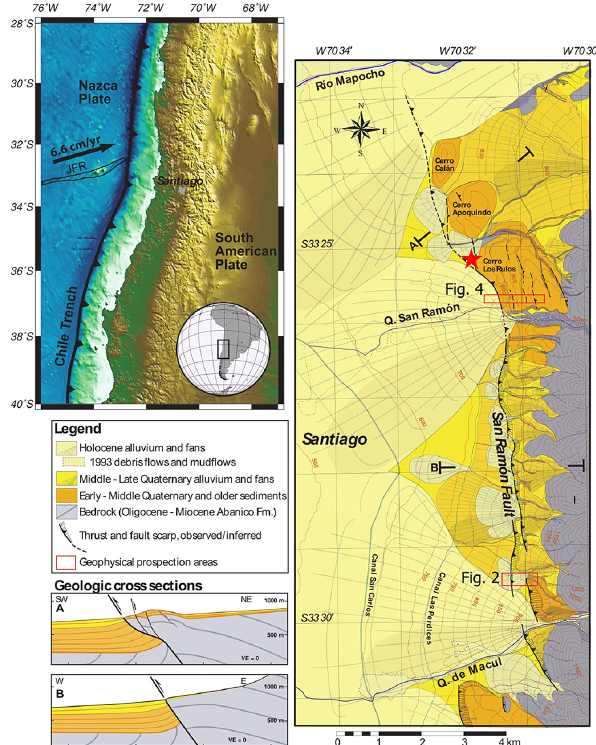
Figure 1. Geological chart (top left panel) and cross sections of the study zone showing the San Ramón fault system along the eastern border of Santiago (bottom left panels), and locations of the geo- physical measurements (right panel) (modified from Armijo et al., 2010). Locations of geophysical measurements are marked by red rectangles, enclosing the areas shown in Fig. 2 (Quebrada de Macul area) and Fig. 4 (La Reina area). A red star marks the position of the Baños de Apoquindo spring.